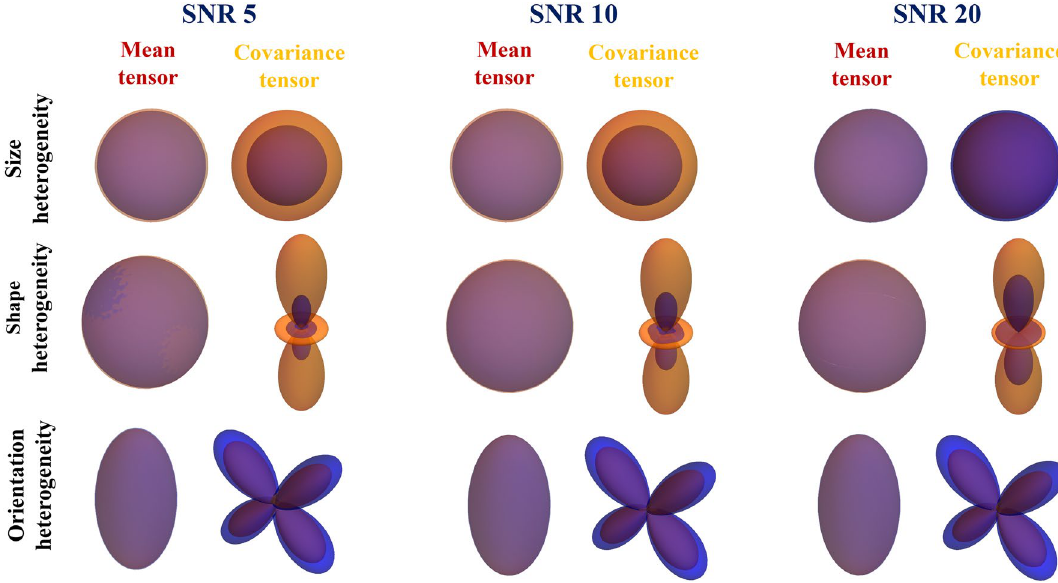
Figure 6. Estimation of mean and covariance tensors from synthetic MR signal for different DTDs with varying signal-to-noise ratio (SNR) at the largest b-value. The mean and covariance glyphs for actual (orange) and estimated (blue) DTD are overlaid. (First row) Isotropic emulsion, (Second row) Shape heterogeneous DTD and (Third row) Crossing fiber type DTD. The reduction in covariance estimation error with increasing SNR is clearly visible in shape and orientation heterogeneous DTD. The above graphics was generated using the Mathematica software 67